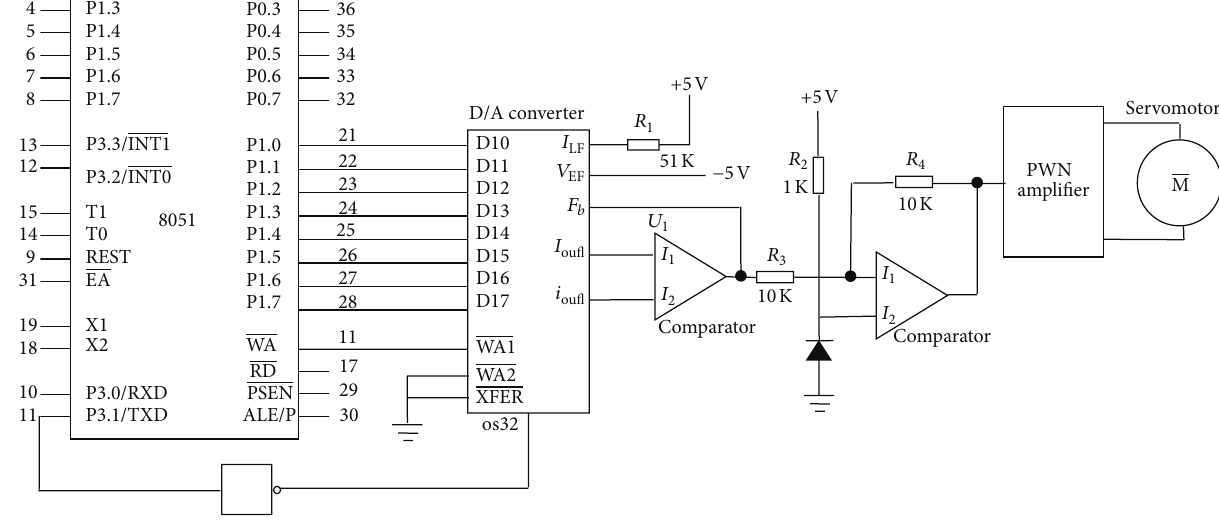
Figure 16: The control unit of the prototype quadruped robot.